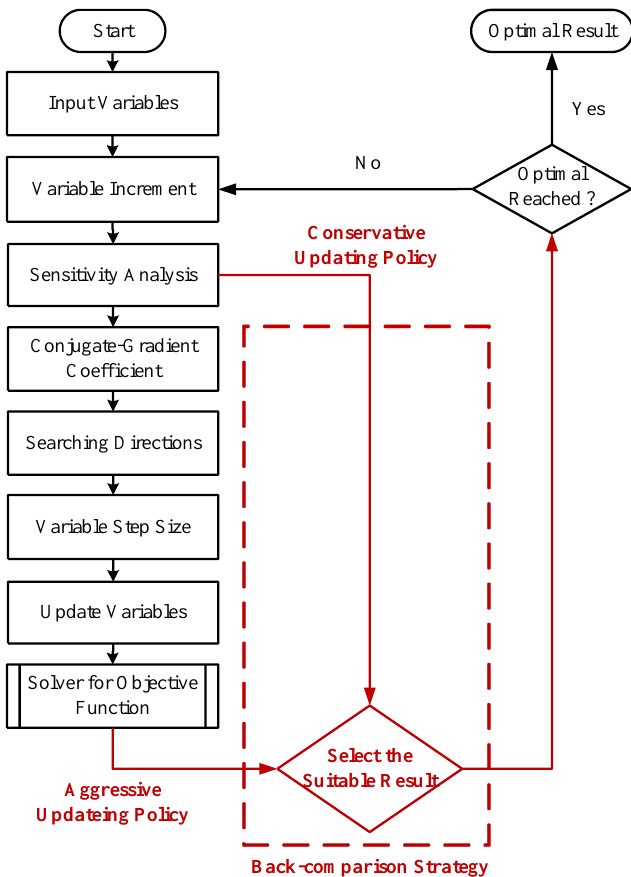
Figure 6. Integration of the backward-comparison strategy with the VSCGM.